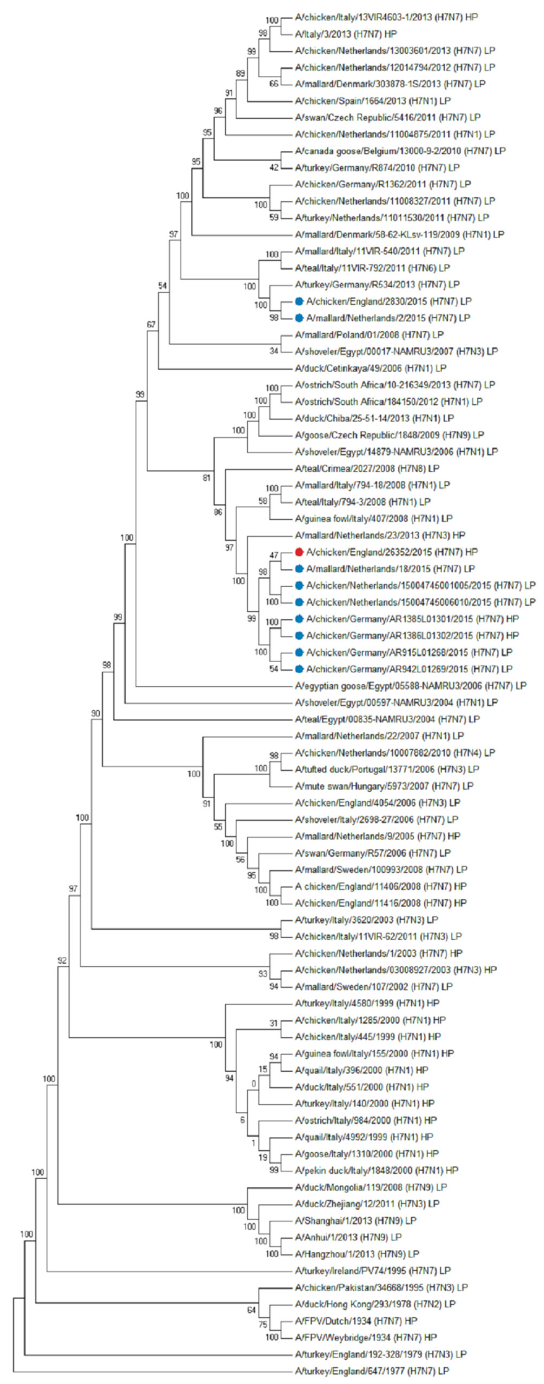
Figure 4. A/chicken/England/26352/2015 is related to contemporary European H7N7 viruses. Sequence comparisons of the HA gene of A/chicken/England/26352/2015 (H7N7) HPAIV identified A/mallard/Netherlands/18/2015 (H7N7) low pathogenicity AIV (LPAIV) to be the closest match at 99.16% identity. A/chicken/England/26352/2015 (H7N7) is indicated by a red circle, whilst European H7N7 influenza viruses from 2015 are indicated by blue circles. Phylogenetic analysis was conducted using a maximum-likelihood approach based on the GTR+F+G4 model. LP; low pathogenicity and HP; high